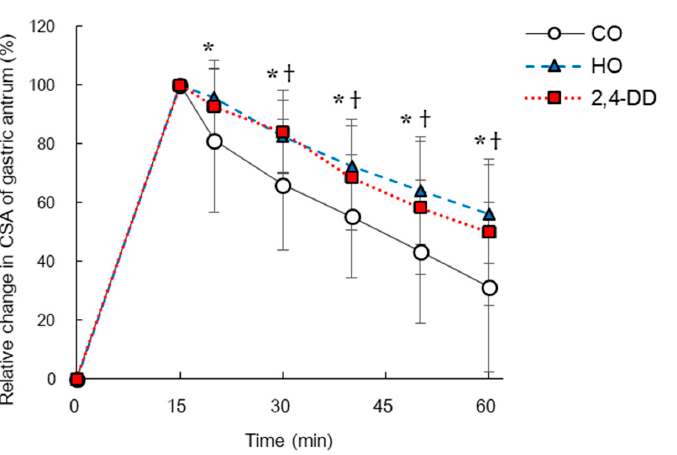
Figure 4. Time course of relative change in CSA of gastric antrum (i.e., % GE) following consumption of pumpkin soup containing 3.1 g of either intact corn oil (CO), heated corn oil (HO), or CO plus 1 mg of 2,4-decadienal (2,4-DD) in Experiment 2. At 15 min after consumption of pumpkin soup, CSA of the gastric antrum was defined as 100%. Mean ± SD. * p < 0.05 (CO vs. HO), † p < 0.05 (CO vs. 2,4 ‐ DD).